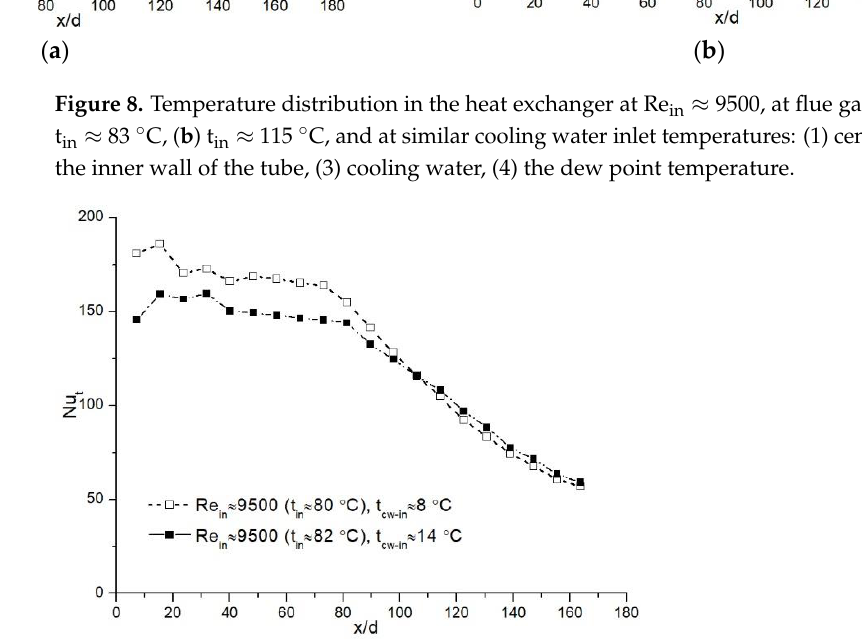
Figure 8. Temperature distribution in the heat exchanger at Re in ≈ 9500, at flue gas temperatures ( a ) t in ≈ 83 °C, ( b ) t in ≈ 115 °C, and at similar cooling water inlet temperatures: (1) center of the tube, (2) the inner wall of the tube, (3) cooling water, (4) the dew point temperature.